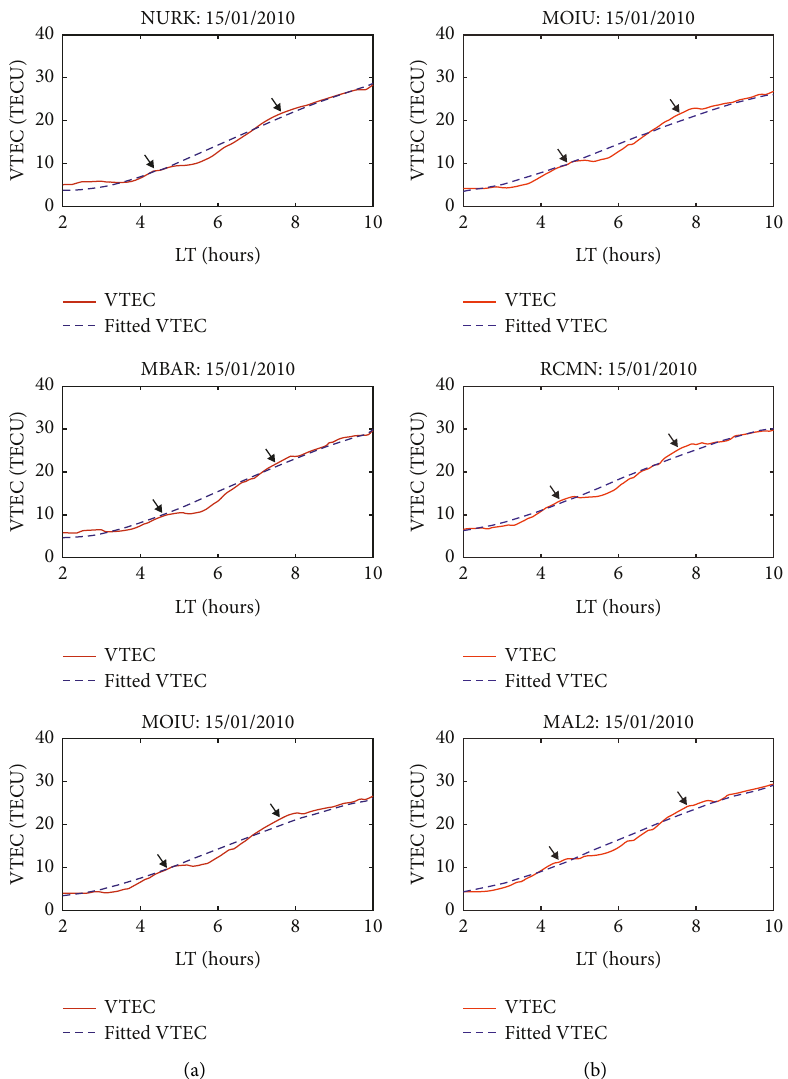
Figure 4: VTEC and fitted VTEC against local time (LT) across (a) NURK-MBAR-MOIU and (b) MOIU-RCMN-MAL2 GPS array on 15 th January